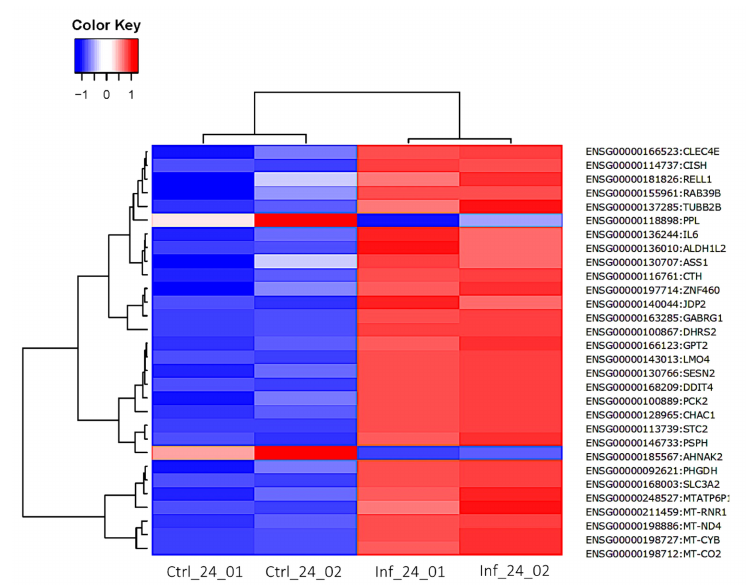
Figure 12. Heatmap generated from the log 2 FC of the top 30 DEGs at 24 hpi. Blue and red colors indicate low and high gene expression, respectively. Gene IDs are indicated on the right side of the heatmap. Columns represent the samples and time points post infection, while rows represent individual genes. The phylogenetic tree above the heatmap demonstrates the hierarchical clustering of the samples. The relationships between the genes are shown on the left tree. For each gene symbol, the respective log2FC and other information can be found in Table S3.